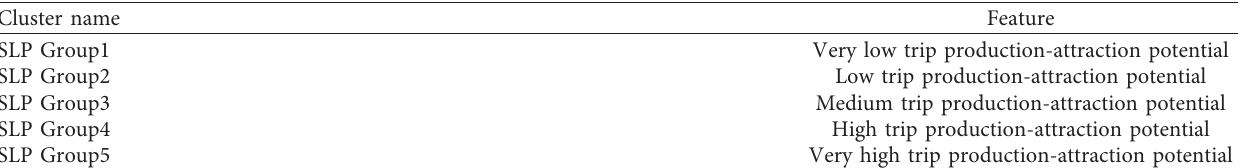
Table 1: Properties of the similar